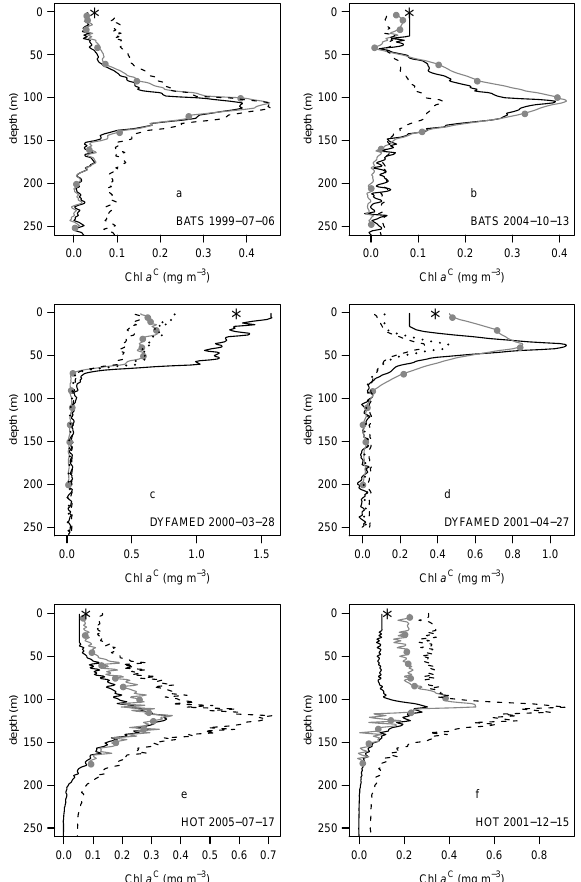
Fig. 2. Examples of “satellite-corrected” profiles (black solid line), “HPLC-calibrated” profiles (grey solid line), factory-calibrated flu- orescence profiles (black dashed line) and, only for DYFAMED ex- amples, “Boss-calibrated” profiles (black dotted lines). As a com- plement, HPLC data points are indicated by grey circles and satellite surface Chl a C by black stars.